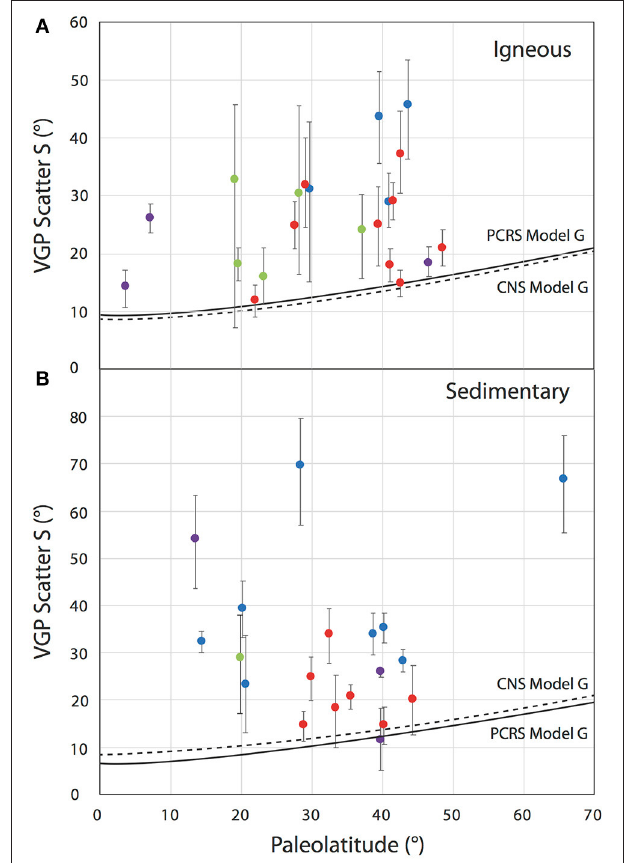
FIGURE 12 | VGP scatter, S, vs. paleolatitude calculated from igneous (A) and sedimentary (B) rock formations of different ages: blue, red, purple and green are for Carboniferous, Permian, Triassic, and Jurassic-Cretaceous data, respectively. Error bars are based on the minimum and maximum values of S determined by bootstrapping. Solid curves are the Model G fit for the Permo-Carboniferous Reverse Superchron (PCRS Model G) of Oliveira et al. (2018) , whereas the dashed curves are the Model G fit for the Cretaceous Normal Superchron (CNS Model G) of Biggin et al. (2008); see text for